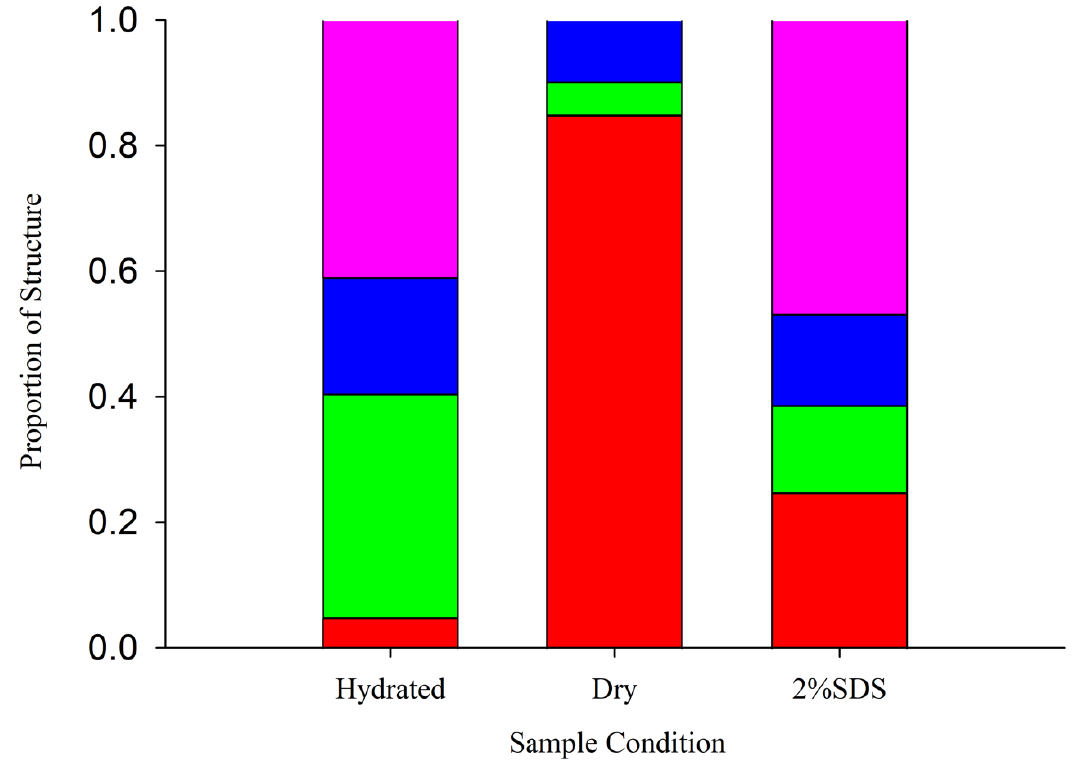
Figure 3. Circular dichroism analysis of hydrated and desiccated Af LEA1, wherein α -helices (red), β -sheets (green), turns (blue), and random coils (magenta) are represented as proportions of the total protein structure. In the hydrated state, the secondary structure of Af LEA1 was on average 5% α -helices, 35% β -sheets, 18% turns, and 42% random coils. In the desiccated state, the secondary structure of Af LEA1 was on average 85% α -helices, 5% β -sheets, and 10% turns. In the presence of 2% SDS, the secondary structure of Af LEA1 was on average of 25% α -helices, 13% β -sheets, 16% turns, and 46% random coils (for CD spectra see Figure S2, Supplementary Materials).